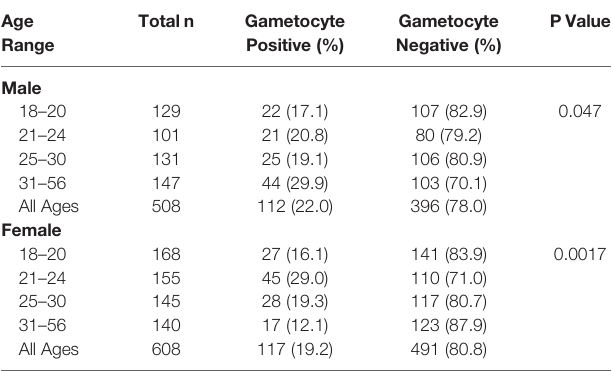
TABLE 2 | Positivity for any gametocyte-speci fi c marker ( pfs16 , pfs48/45 or pfs25 ) by gender and age. Age